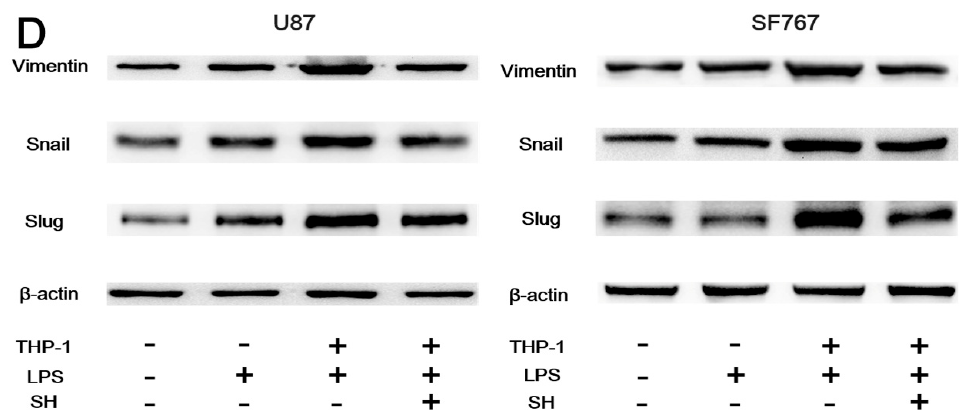
Figure 5. SH inhibits the EMT and invasion of the human glioblastoma cells in the inflammatory microenvironment. ( A ) Levels of the inflammatory cytokines tumor necrosis factor- α (TNF- α ) and interleukin-1 β (IL-1 β ) in the medium of U87 and SF767 cells that had been treated with lipopolysaccharides (LPS) (10 ng/mL), the medium of THP-1 cells or THP-1-CM for 24 h were assessed using enzyme-linked immunosorbent assays (ELISAs); ( B ) The viability of U87 and SF767 cells that had been treated with THP-1-CM or THP-1-CM containing SH (0.25 mM) for 24 h was investigated using CCK-8 assays; ( C ) Invasion assays were conducted using Transwell inserts covered with matrigel. Cells treated with LPS (10 ng/mL), THP-1-CM or THP-1-CM containing SH (0.25 mM) for 24 h were subjected to matrigel-coated Transwell invasion assays (100 × magnification); ( D ) Western blot analysis was applied to investigate the levels of vimentin, Snail and Slug in cells incubated with LPS (10 ng/mL), THP-1-CM or THP-1-CM containing SH (0.25 mM) for 24 h. Each blot and image shown is representative of n = 3 experiments. β -Actin served as the loading control. All data are presented as means ± SEM, n = 3. ** p < 0.01 compared with the control; ## p < 0.01 compared with the LPS- or THP-1-treated group for the results shown in A or ## p < 0.01 compared with the THP-1-CM-treated group for the results shown in C. THP-1: the medium of THP-1 cells; THP-1-CM: the medium of THP-1 cells stimulated with LPS (10 ng/mL) for 24 h.